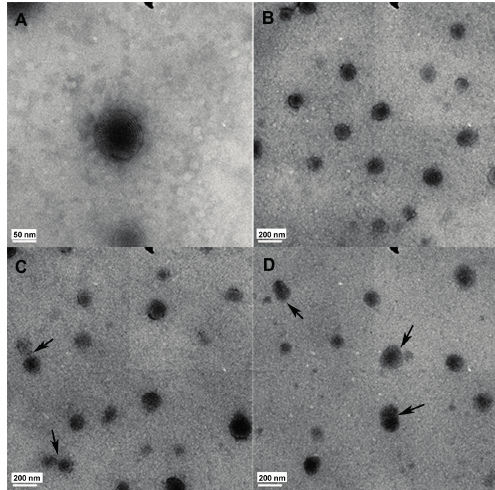
1. Transmission electron (TEM) images of ethosomal gel carried with 5-Fluorouracil (5-FU). ( A , B ) Freshly prepared 5-FU Ethosomal Gels (EGs); ( C ) 5-FU EGs stored at 4 ± 1 °C for 30 days; ( D ) 5-FU EGs stored at 25 ± 1 °C for 30 days; Black arrow indicated these vesicles of ethosomal